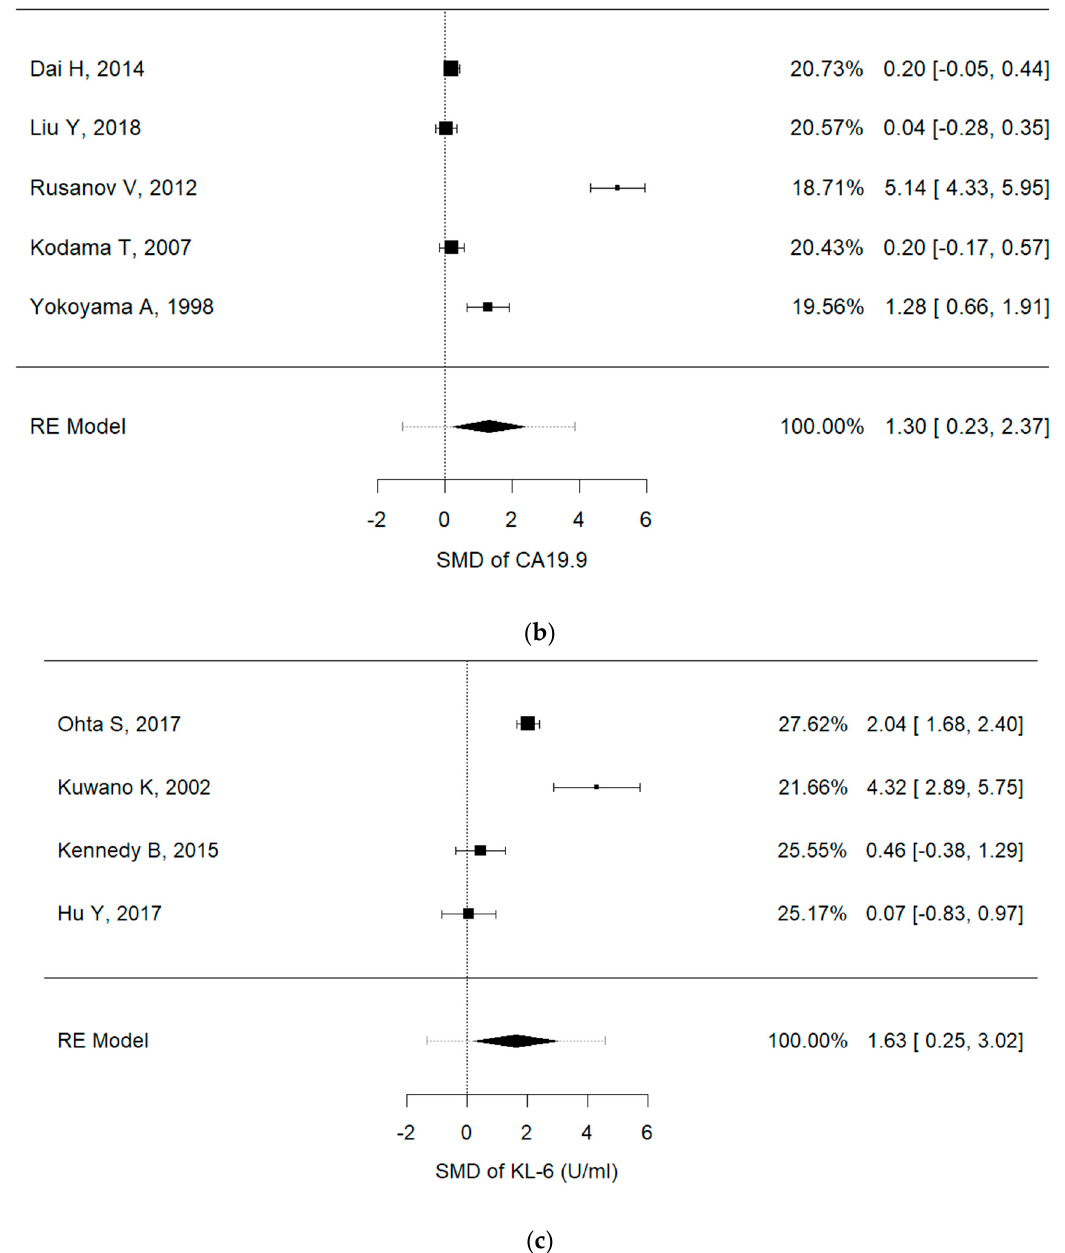
Figure 3. ( a ) Metanalysis results from Ca15.3 concentrations of selected studies, ( b ) metanalysis results from Ca19.9 concentrations of selected studies, ( c ) metanalysis results from KL-6 concentrations of selected studies.